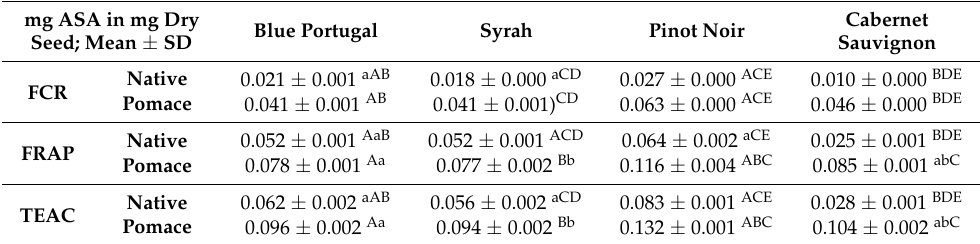
Table 2. Total antioxidant capacity (FCR, FRAP, TEAC) of native grape seed and grape pomace of four different grape varieties harvested in the Vill á ny wine